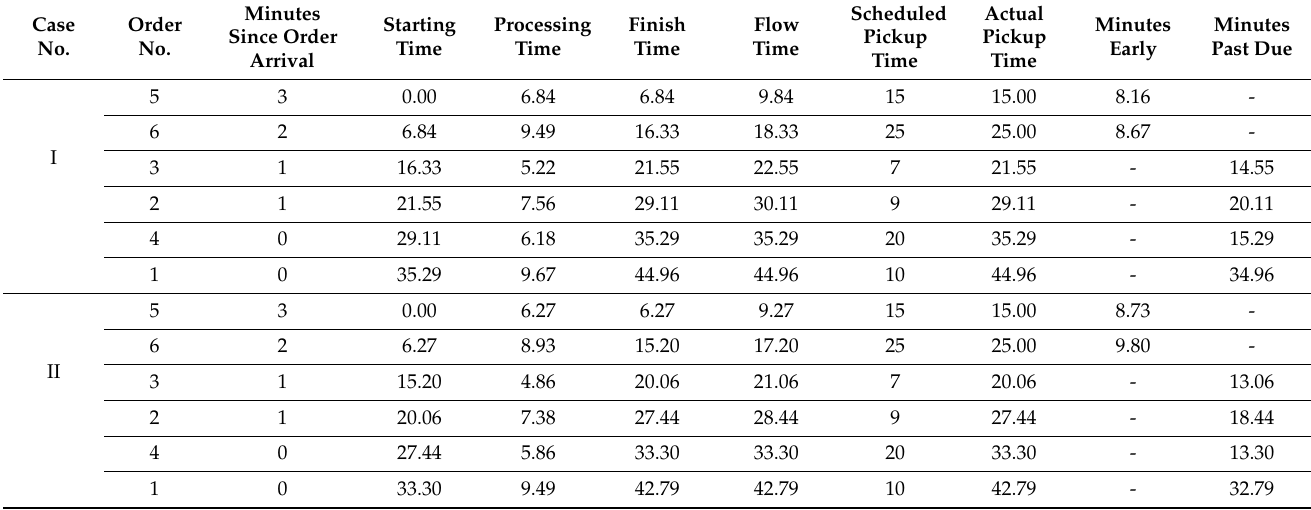
Table 8. Sequence of orders based on the FCFS